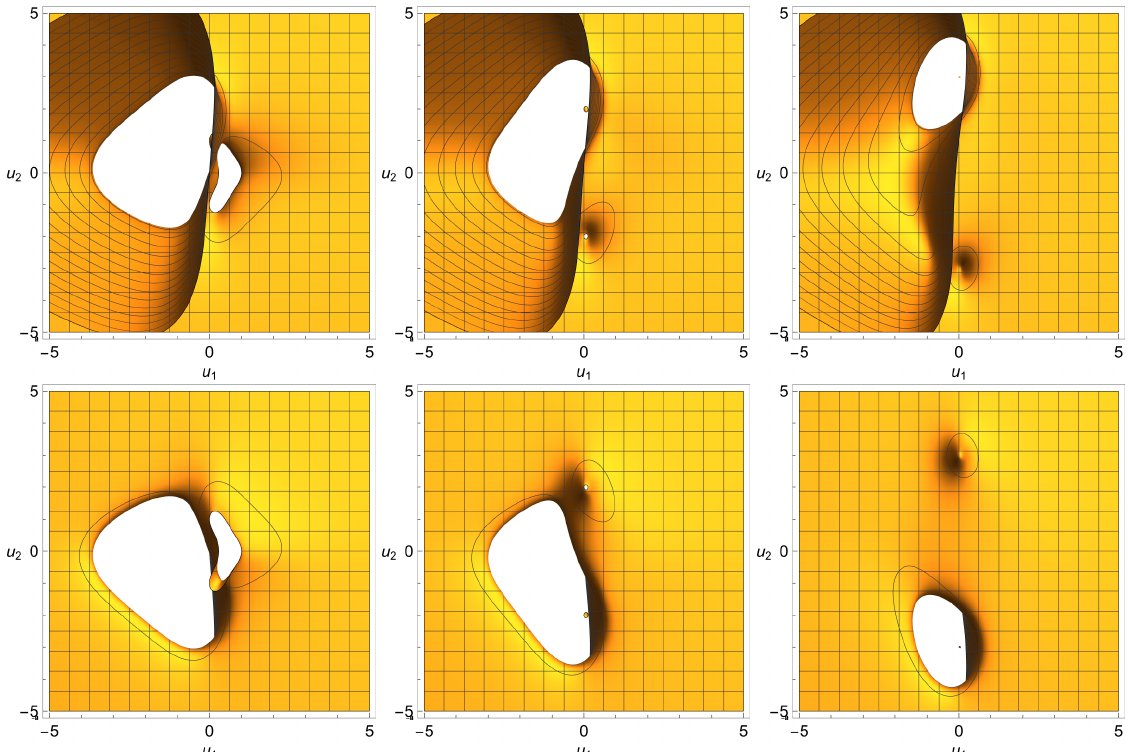
Figure 11. The three figures in the first row (from left to right) show the evolution of the topolog- ( 2 )+ ( t ) from the asymptotic state ( in ) with data (cid:0) Ω − ical singularities of the submanifold Σ u (cid:1) ε ( r ) = 1, ε ( i ) = 0.5 , to ( out ) an asymptotic state where the frequency is Ω + (from left to right), there are figures showing a similar evolution for the sub-manifold Σ